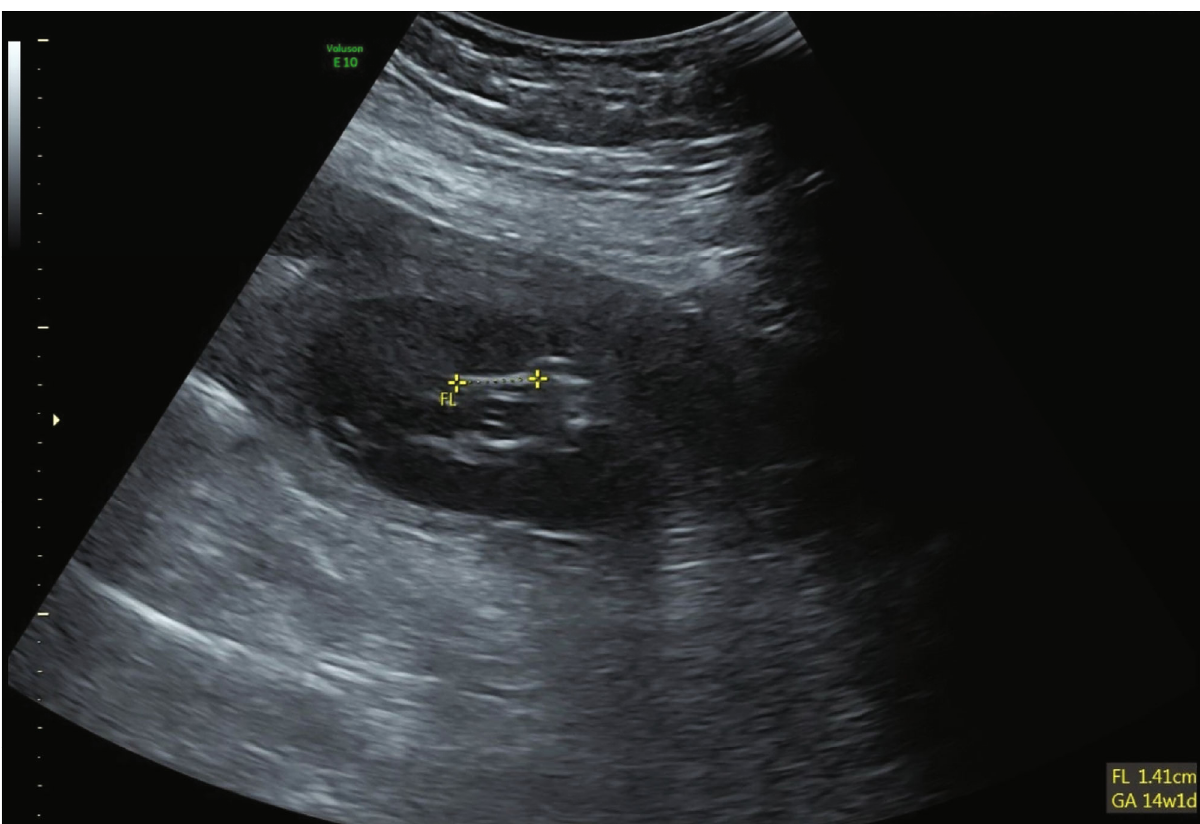
Figure 4: Ultrasound shows the femur length (FL) measuring 1.41cm which equals 14 weeks and 1